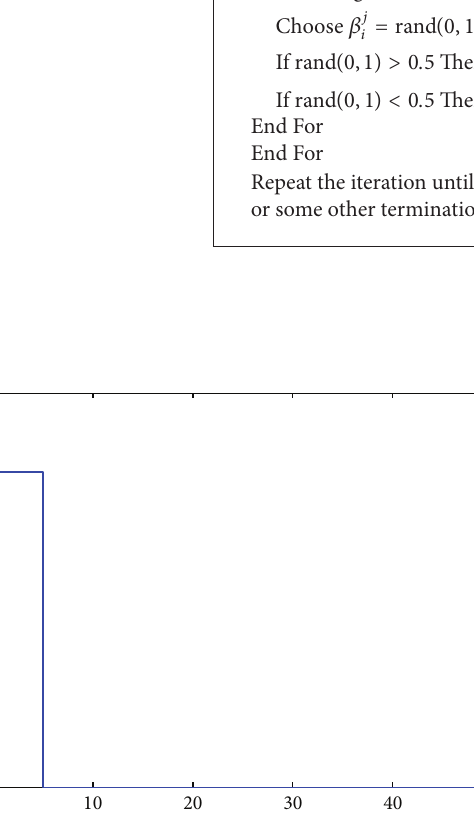
Figure 1: Figure of the probability density function 𝑄 1 . Figure 2: Figure of the probability density function 𝑄 2